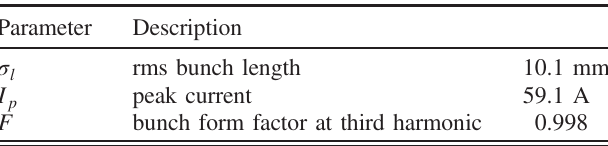
TABLE II. Equilibrium bunch parameters without harmonic cavities.